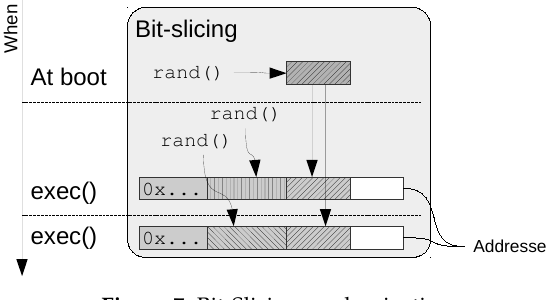
Figure 7. Bit-Slicing randomization.